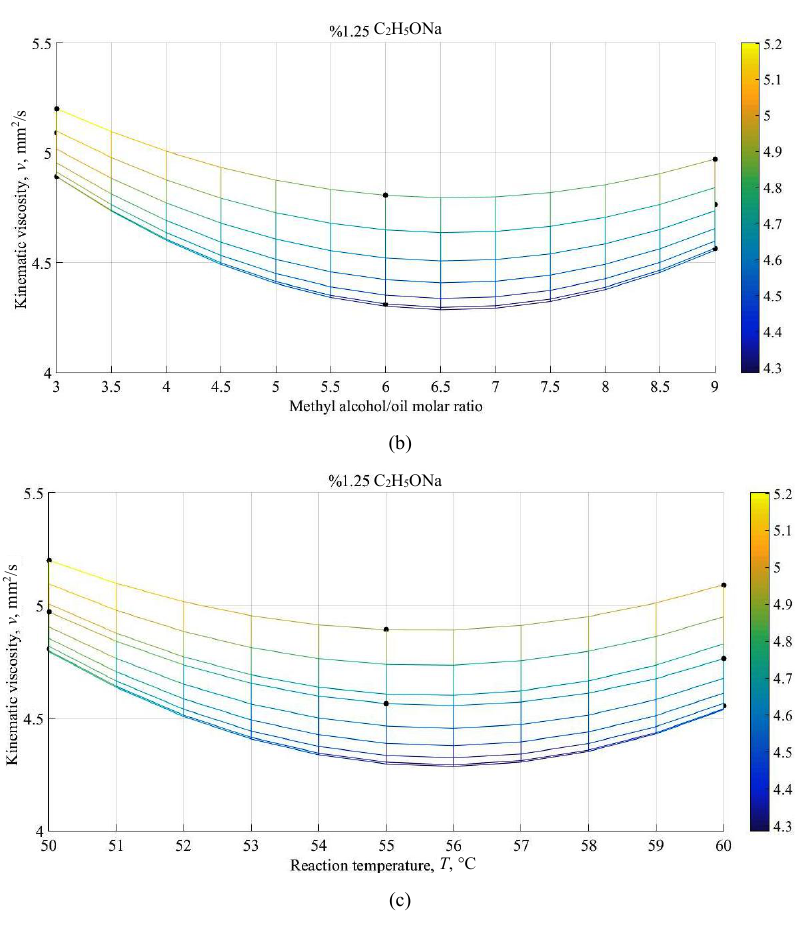
Fig. 3. Change of methyl ester viscosity (a) vs. reaction temperature and alcohol/oil molar ratio simultaneously; (b) alcohol/oil molar ratio; (c) reaction temperature for the catalyst concentration of 1.25 %. The change of methyl ester viscosity is more clear in case of using 1.00 % and 1.25 % catalyst concentrations. In other words, variation in viscosity of methyl ester is slighter for catalyst concentration of 0.75 % then 1.00 % and 1.25 %, as seen in Fig. 1–3(a). In addition, variation in catalyst amount does not significantly affect the behavior of change in ethyl ester viscosity with respect to reaction temperature and alcohol/oil molar ratio simultaneously, as seen in Fig. 4–6(a). In other words, the similar characteristics in the viscosity change of ethyl esters were obtained for different catalyst amounts (0.75 %, 1.00 % and 1.25 %). As shown in these figures, methyl and ethyl esters having higher viscosity were produced at lower reaction temperatures (e.g. 50 °C for methanolysis and 60 °C for ethanolysis) and alcohol/oil molar ratios (e.g. 3:1 for methanolysis and 9:1 for ethanolysis). However, as temperature and molar ratio are increased until the specific parametric values, viscosity decreases and lowers to a minimum. However, after these parametric values, when temperature and molar ratio continue to increase, viscosity tends to increase as